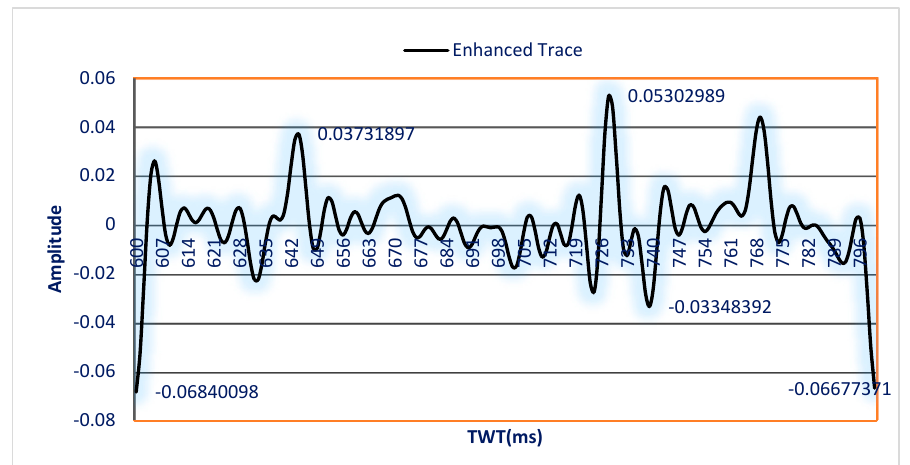
Figure 12. A plot of the bandwidth-enhanced seismic trace model parameter showing an improved resolution after harmonic extrapolation was applied to the original spectrum.